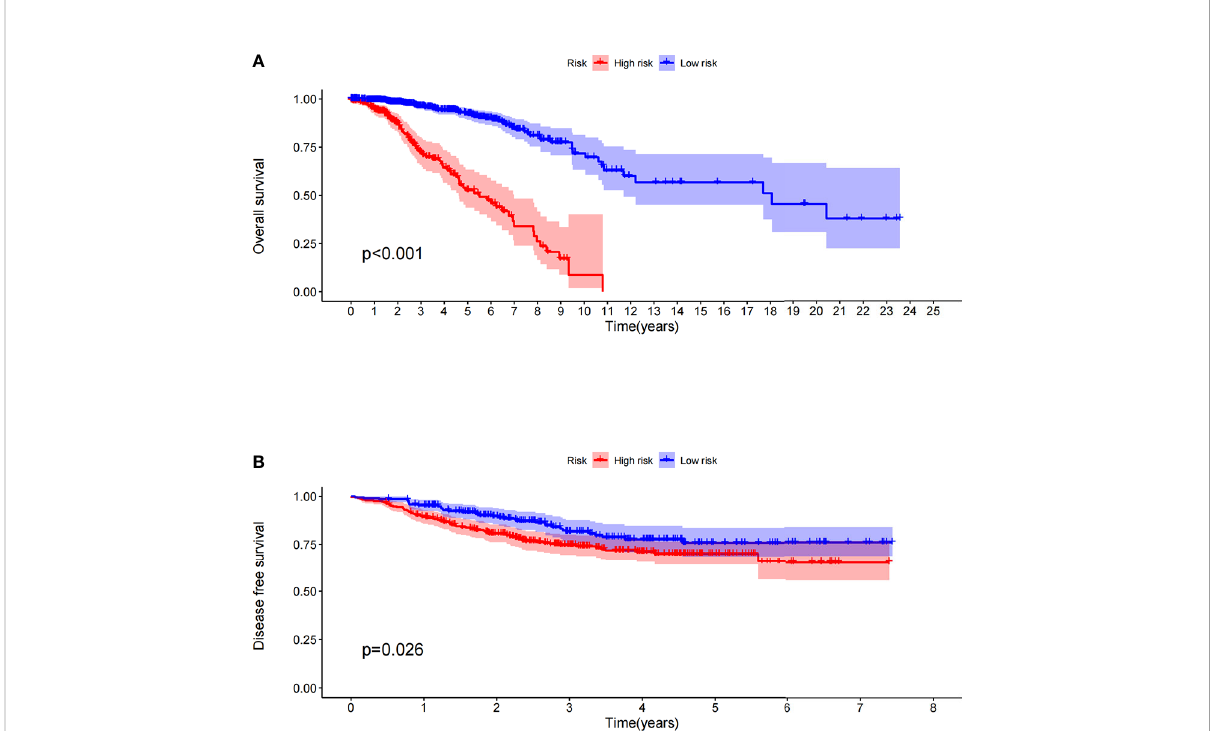
positive patients (Figure 3B, P < 0.001), in the HER2-positive patients vs. the HER2-negative patients (Figure 3C, P < 0.001), in the patients aged ≤ 60 years old vs. those aged >60 years old (Figure 3D, P < 0.001), and in patients that had undergone chemotherapy vs. those without chemotherapy (Figure 3E, P <